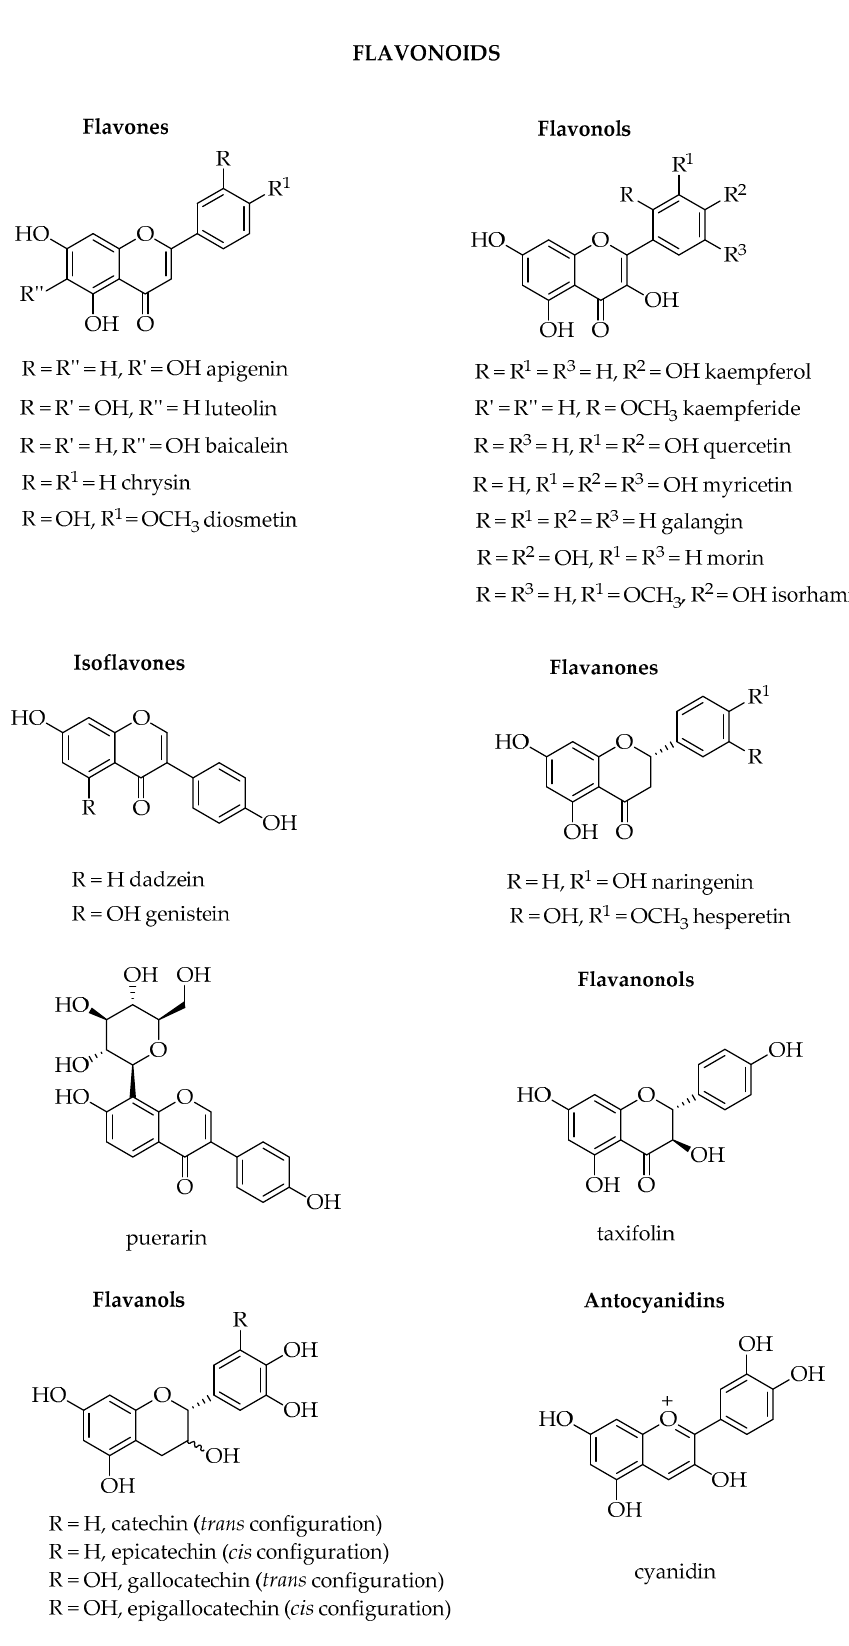
Figure 1. Figure 1. Flavonoids.